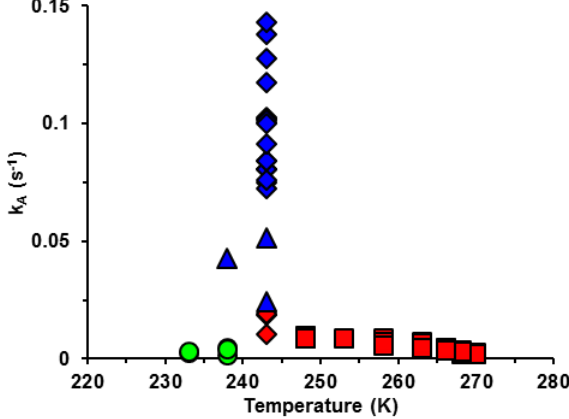
Figure 7. Temperature dependence of the KJMA rate constants, k A , for the crystallization of the R = 3 hydrate of zinc chloride. DSC experiments are represented as the red squares (pans) and diamonds (capillaries), TtXRD experiments as blue triangles (bulk analysis) and blue diamonds (single diffraction spot analysis), and TtND as green circles.